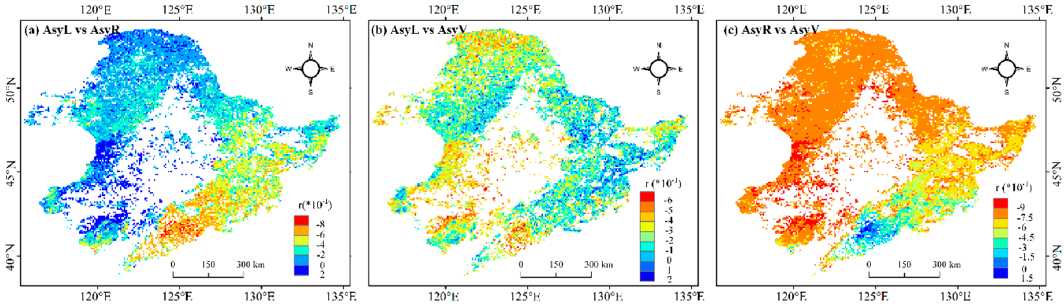
Figure 7. Spatial distribution of correlation coefficient of three asymmetric indices (white cells denote insignificant correlations).